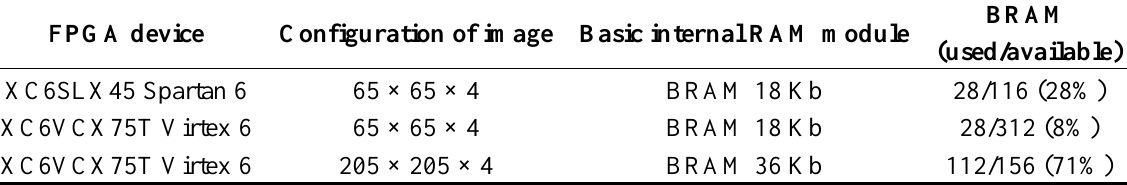
Table 2. FPGA internal memory resources. BRAM: Block